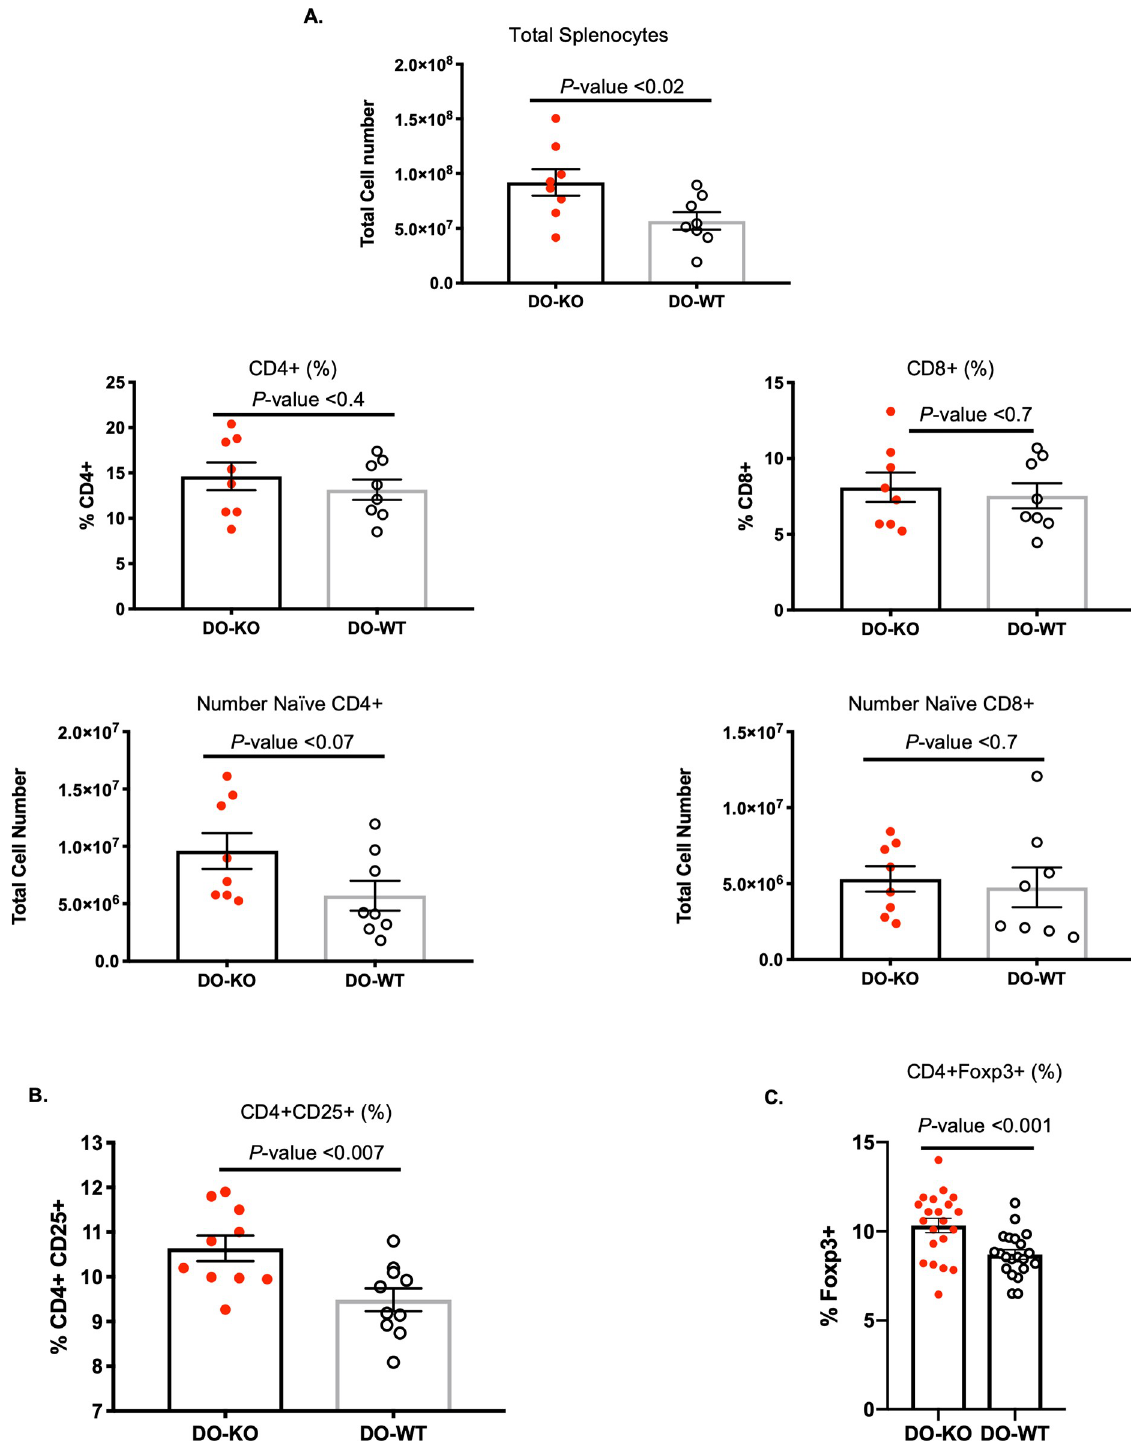
Fig 2. Na ï ve DO-KO mice have an expanded CD4 T-cell compartment as well as increased expression of Tregs. (A) Breakdown of T-cell compartment in the spleens of na ï ve DO-WT (white) and DO-KO (red) mice. N = 8 mice per group. Data are represented as mean ± SEM. (B). Subdivision of the CD4 T-cell compartment showed that DO-KO mice have increased percentage of CD4 + CD25 + –expressing cells. N = 8 mice per group. Data are represented as mean ± SEM. (C). Na ï ve expression of the Foxp3 transcription factor in na ï ve CD4 + T cells from DO-WT (white) and DO-KO (red) mice. N = 21 mice per group. Experimental results depicted in this figure can be found in S2 Data. Data are represented as mean ± SEM. DO, HLA-DO; Foxp3, forkhead box P3; KO, knockout; Treg, regulatory T cell; WT, wild-type.